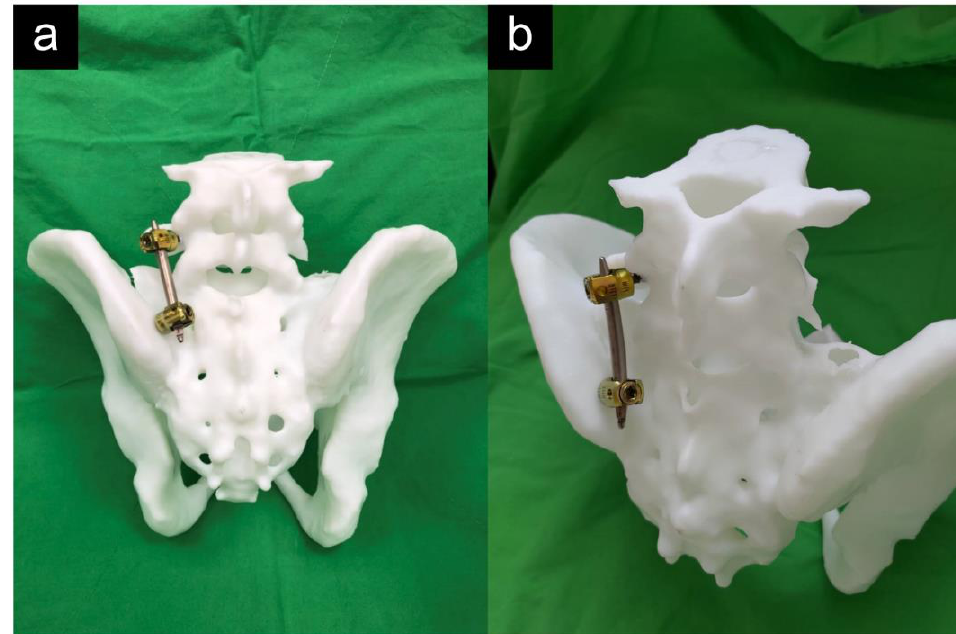
Figure 2. Minimally invasive spinopelvic fixator in three-dimensional printing model. ( a ) Posterior view of the spinopelvic fixator. ( b ) Oblique view of the spinopelvic fixator and the entry point of iliac screw located at the recess below the posterior iliac spine. The screw head can hide under the bony prominence. This 1:1 3D printing bone model is supported by the Medial 3D Printing Center, Tri-Service General Hospital, National Defense Medical Center, Taipei, Taiwan.